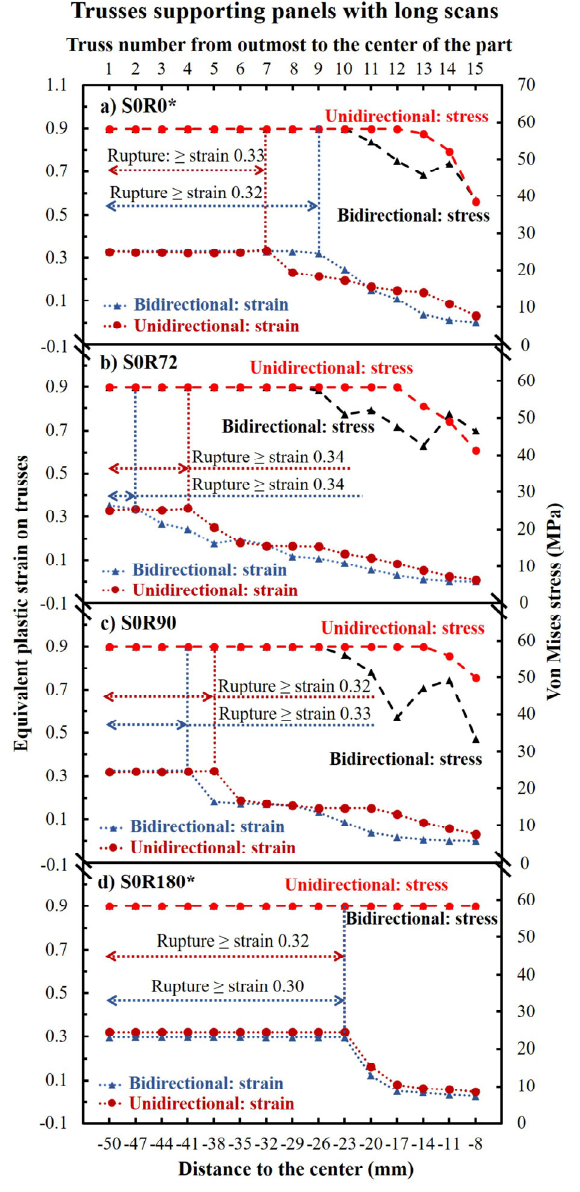
Figure 14. The equivalent plastic strain and von Mises stresses on each truss of the parts made with long scans. Note that the unidirectional S0R0 and S0R180 parts only had a panel thickness of 1.15 mm (instead of 2 mm) due to stopping the process after excessive bending. * The unidirectional S0R0 and S0R180 panels were only 1.15 mm (instead of 2 mm) thick due to the process failure after excessive bending.